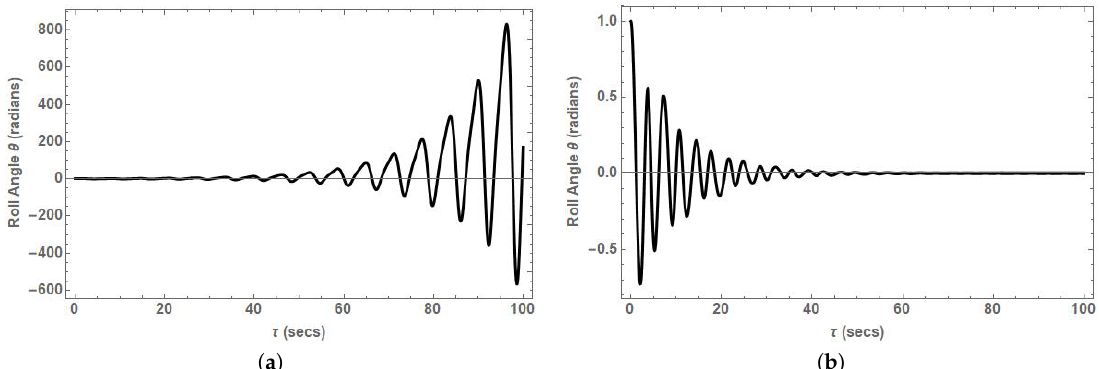
Figure 10. Comparison of roll angle variations of the SSF system with significant linear damping and an additional rotational damper ( C = 0.2) ( a ) when q t = 0.5, a = 1.0, ( b ) when q t = 1.5, a =